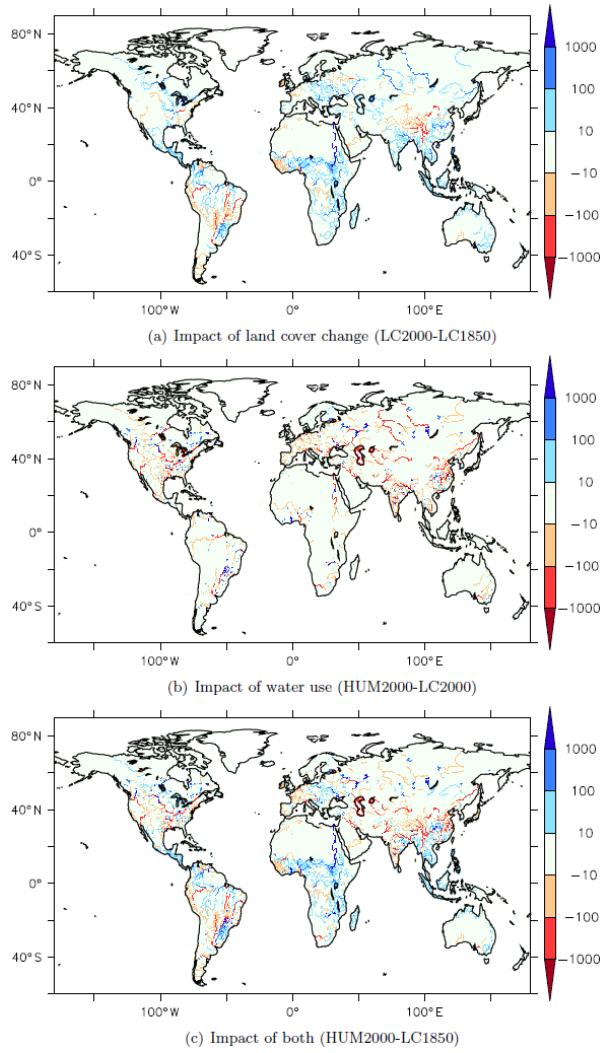
Figure 6. Difference in annual total land surface evapotranspiration between the experiments, averaged over 1979–2010 (in mmyr − 1